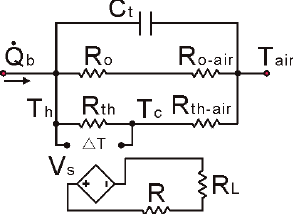
Figure 2. Model of thermoelectric generator with a